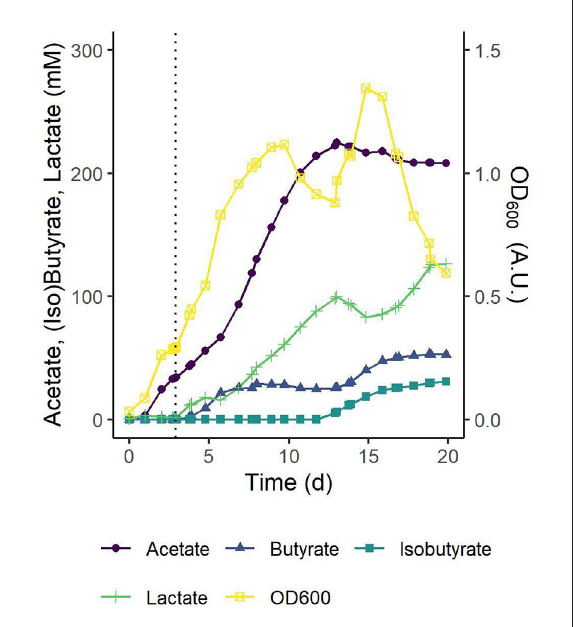
FIGURE8 pH-controlled fed-batch fermentation of the